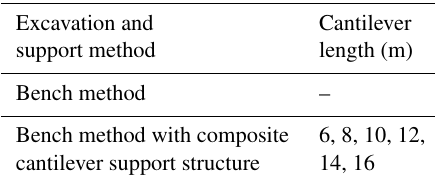
Table 2. Model calculation conditions.